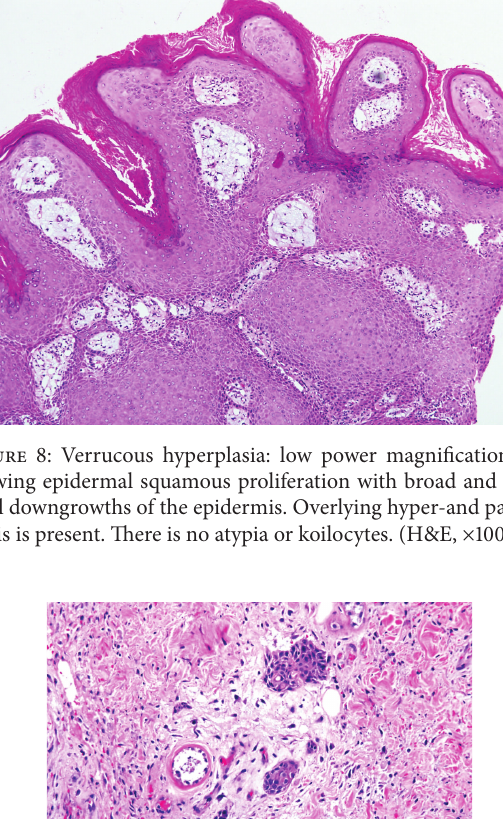
Figure 7: Infundibulocystic SCC: superficial areas showing infundibulocystic canals with deeper infiltrative squamous cell clusters featuring cellular atypia and mitoses (arrow). (H&E, × 100).